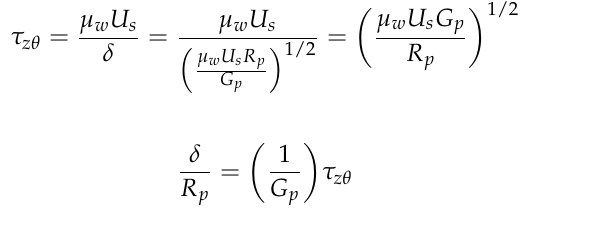
Figure 8. Wall slip velocity, U s , versus shear stress at the edge, | τ z θ ( R ) | , from the data collected at three gaps in the plug flow region.